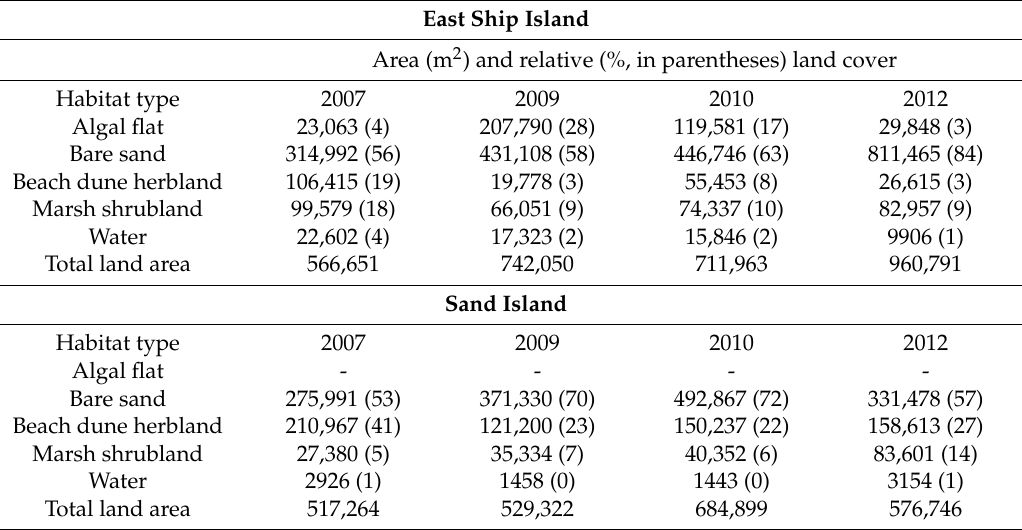
Table 2. Total and relative land cover of East Ship and Sand habitat types in 2007, 2009, 2010 and